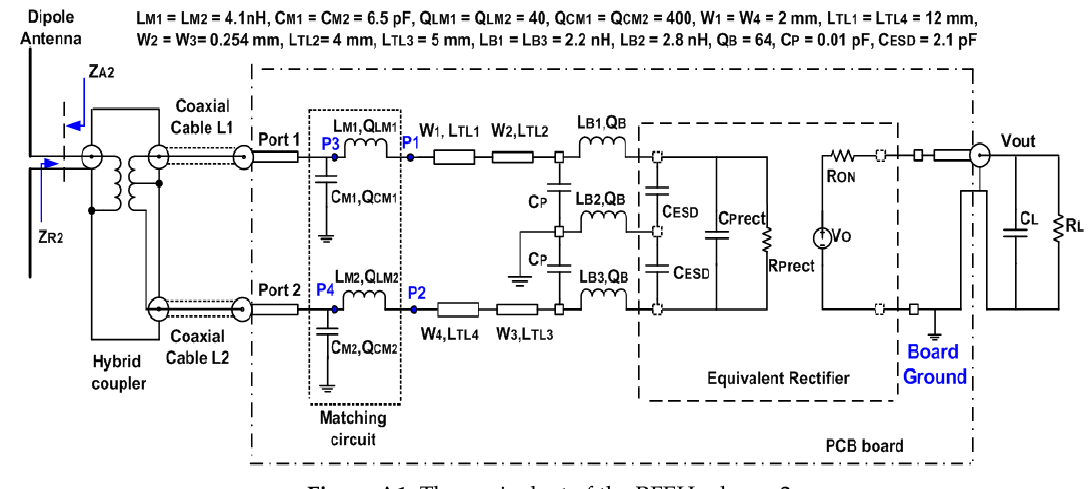
Figure A1. The equivalent of the RFEH scheme